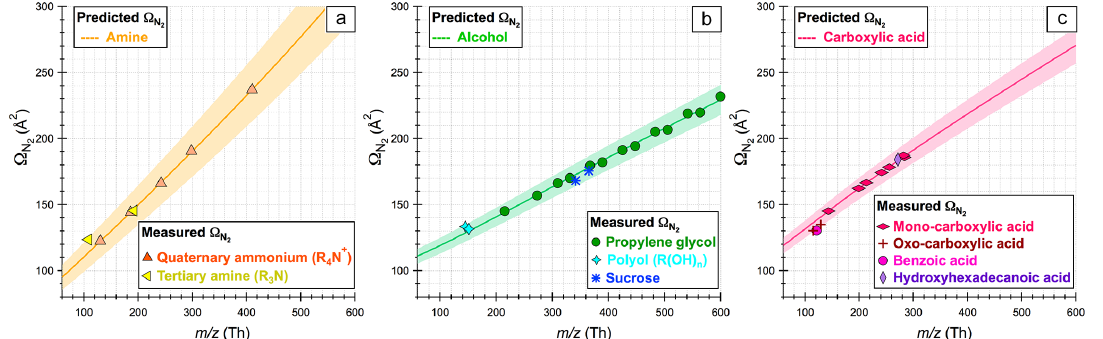
) for (a) tertiary-amine and quaternary-ammonium, (b) (di/poly/sugar-)alcohol, Figure 2. Measured collision cross sections ( (cid:127) N 2 and (c) (mono/oxo/hydroxy-)carboxylic acid as a function of the mass-to-charge ratio. Also shown are the predicted (cid:127) N lines for amine, alcohol, and carboxylic acid by the core model. Here, quaternary-ammonium, propylene glycol, and C 8 -C 18 alkanoic-acid are used to optimize the adjustable parameters in the core model (the markers are in the same color as the trend lines). The colored shade in each figure represents the maximum deviations (8.21, 3.54, and 6.69% for amine, alcohol, and carboxylic acid, respectively) of the predicted (cid:127) N from the measured (cid:127) N for species that are not used to constrain the core model. A single plot showing the separation of these three 2 2 chemical classes is given in Fig.